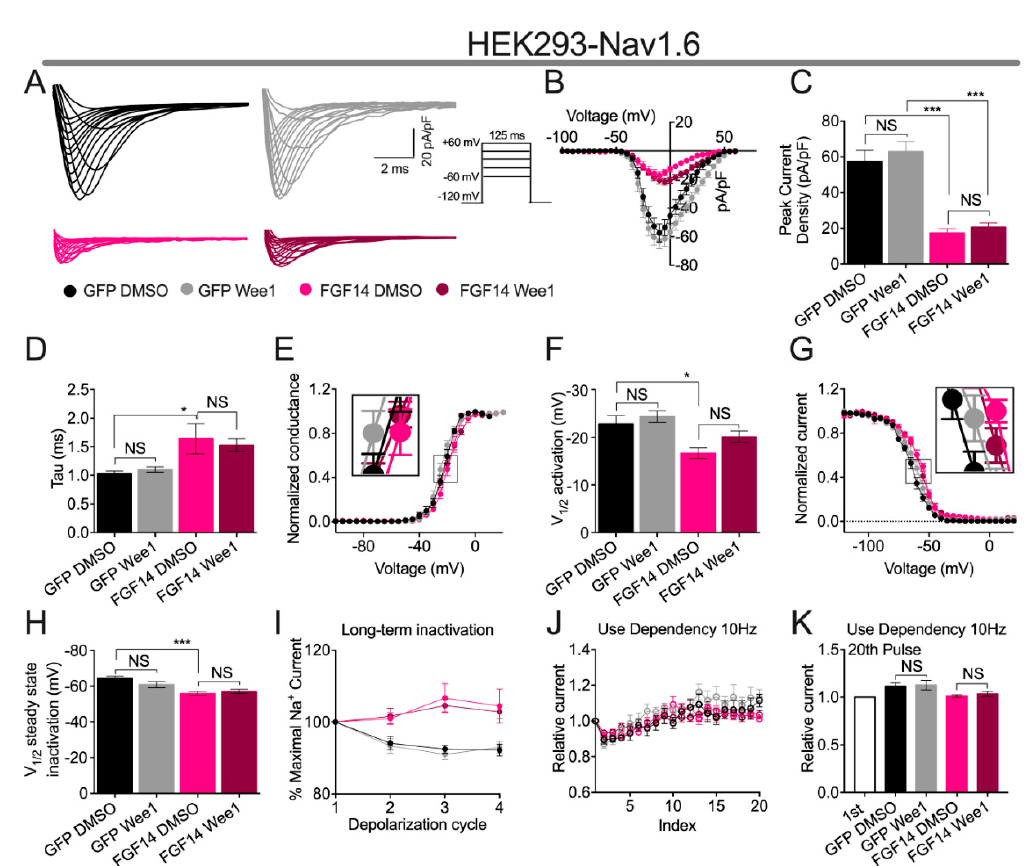
Figure 4. Wee1 inhibitor II does not affect FGF14-mediated regulation of the Na v 1.6 channel. ( A ) Representative traces of I Na elicited by cells of the indicated experimental groups in response to the depicted voltage-clamp protocol. ( B ) Current– voltage relationships of cells from the experimental groups described in ( A ). ( C ) Peak I Na density of cells from the indicated experimental groups. ( D ) Tau of fast inactivation of cells from the indicated experimental groups. ( E ) Voltage-dependence of activation of cells from the experimental groups described in ( A ). ( F ) V 1/2 of activation of cells from the indicated experimental groups. ( G ) Steady-state inactivation plots of cells from the experimental groups described in ( A ). ( H ) V 1/2 of steady-state inactivation of cells from the indicated experimental groups. ( I ) Characterization of entry of Na v 1.6 channels into long-term inactivation for the experimental groups described in ( A ). ( J ) Characterization of cumulative inactivation of Na v 1.6 channels for the experimental groups described in ( A ). ( K ) Relative current at the 20th pulse (normalized to the I Na amplitude observed during the first depolarization) for the indicated experimental groups. Data are mean ± SEM. Significance was assessed using a one-way ANOVA with post hoc Tukey’s multiple comparisons test. *, p < 0.05; ***, p < 0.001. Data are summarized in Tables 3 and 4.